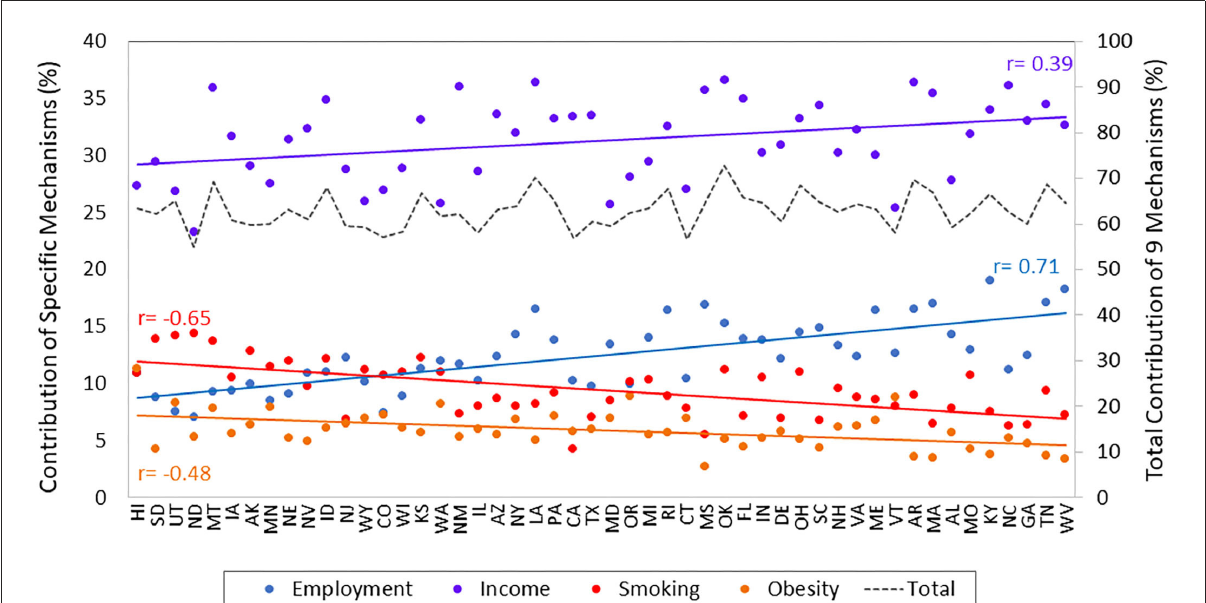
FIGURE2 Contribution of four key mechanisms to the education-health association in U.S. states. Data are from the 2011–2018 BRFSS and include adults ages 25–64 years. States are ordered from left to right in ascending order of the strength of their education-health association. r = correlation between the strength of the education-health association in each state and the percentage contribution of each mechanism.